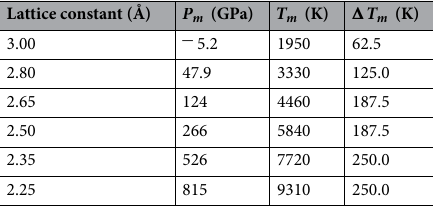
� T m ) , obtained from the Z method ±